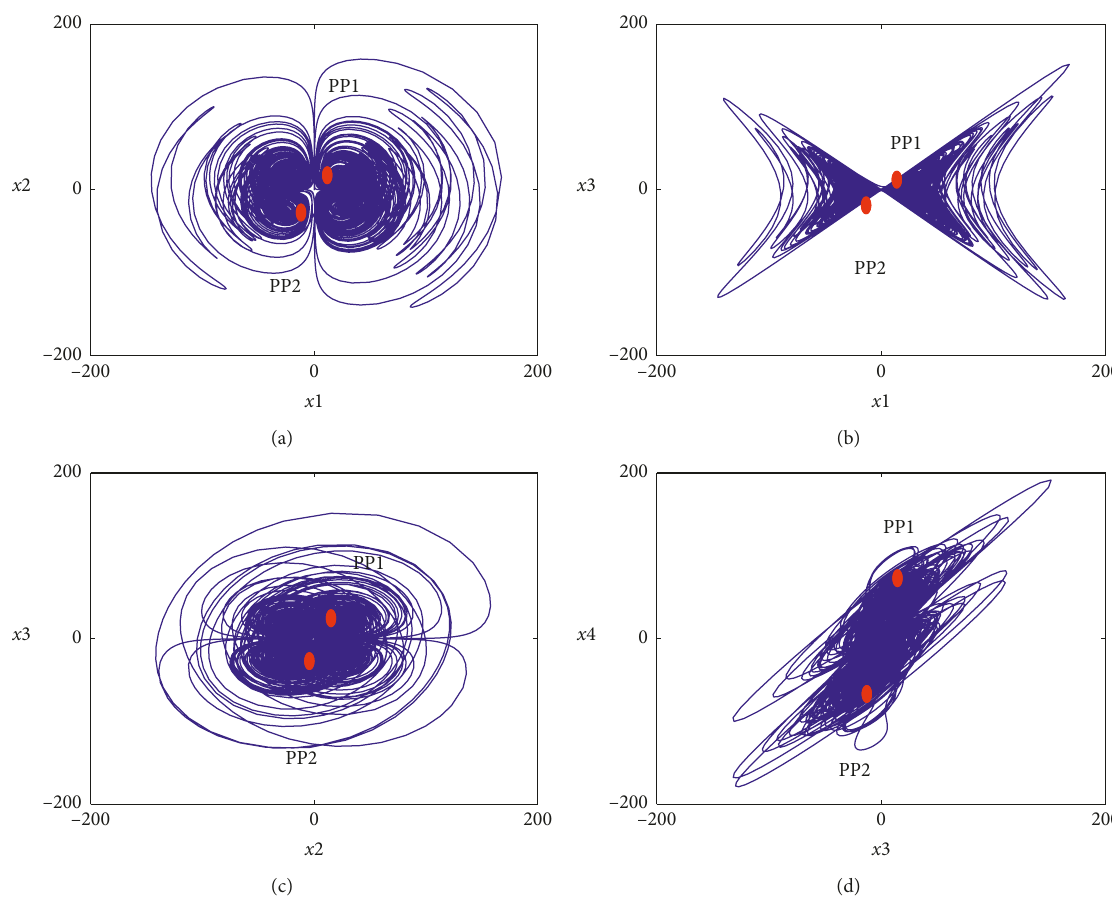
− x plane, (b) x 1 2